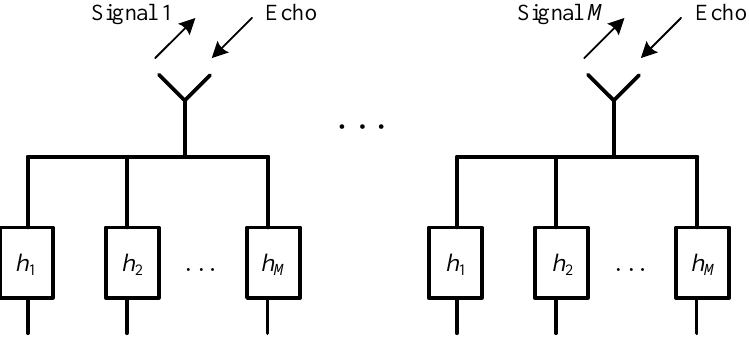
Figure 1. A monostatic MIMO radar with M antennas for transmitting and receiving.